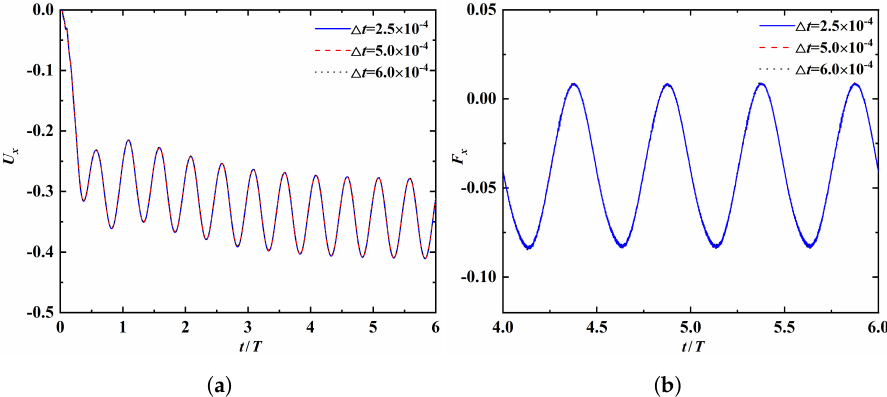
Figure A2. Time histories of ( a ) the leading-edge’s horizontal velocity and ( b ) the horizontal fluid force, obtained by using three different time − step